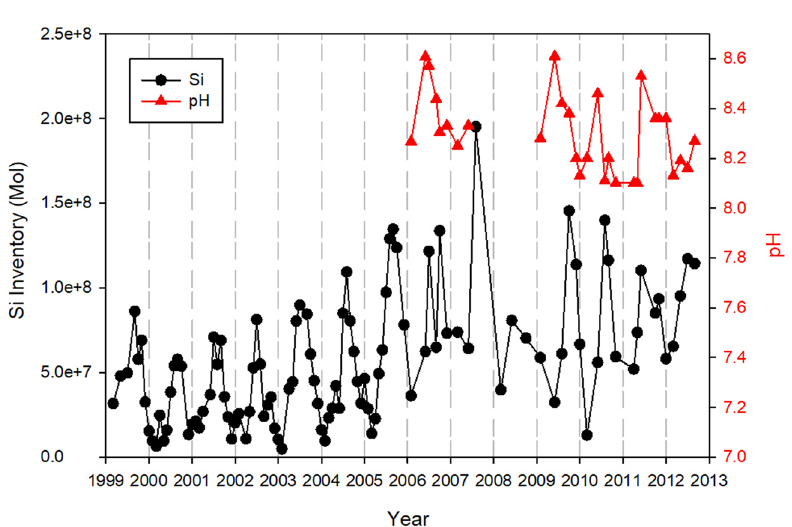
Figure 5. Seasonal and inter-annual changes in maximum pH and inventory of dissolved silicon in Florida Bay over the period of